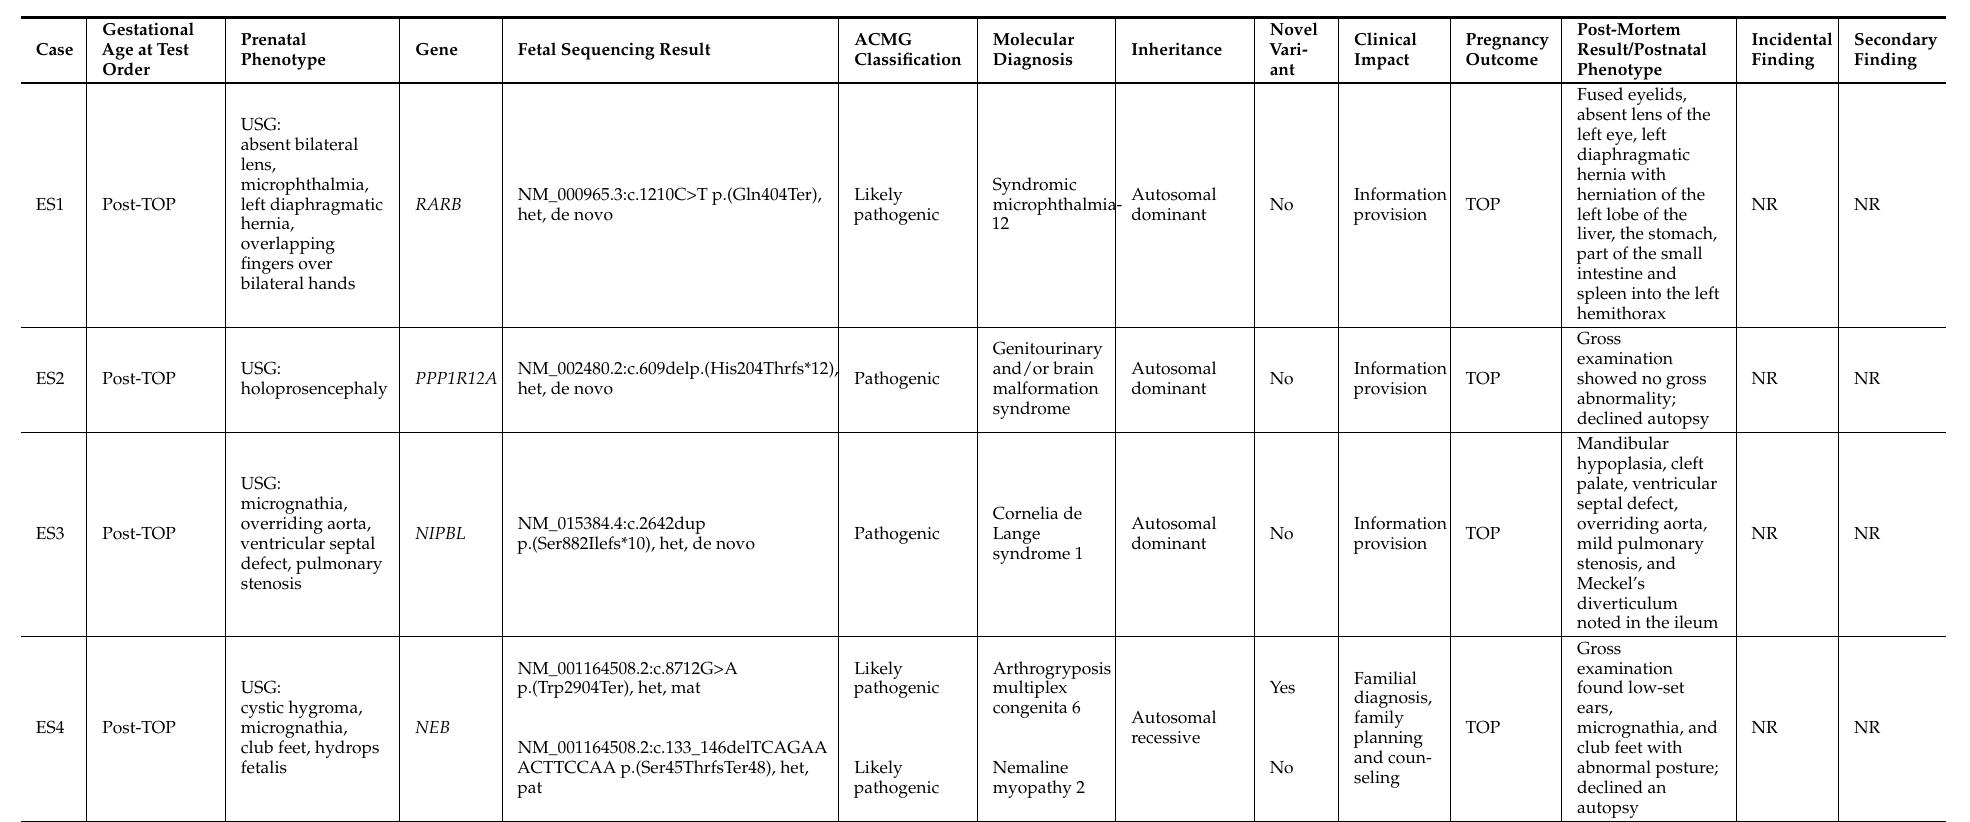
Table 2. Results of whole exome